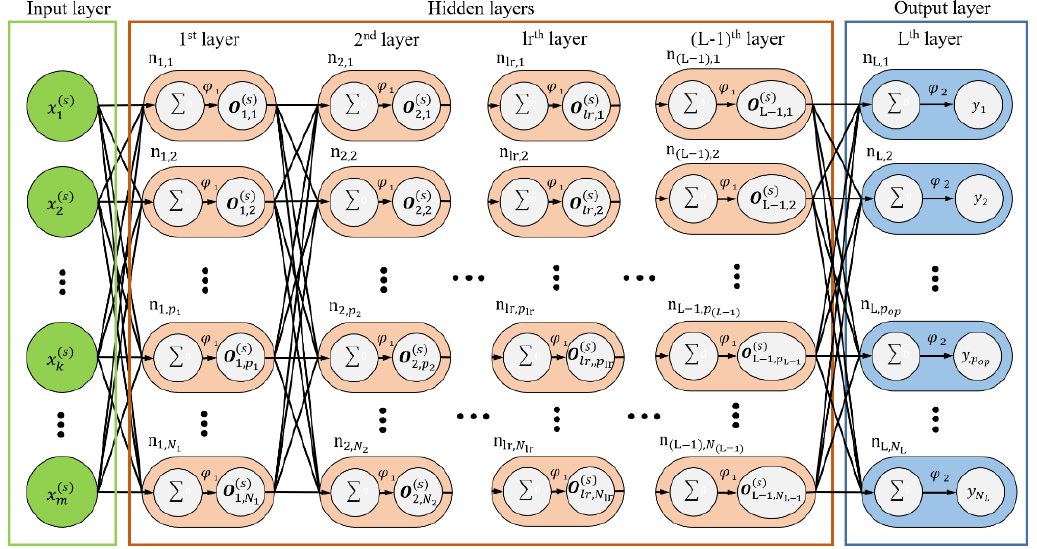
Figure 3. Structure of the multilayer perceptron (MLP) model.